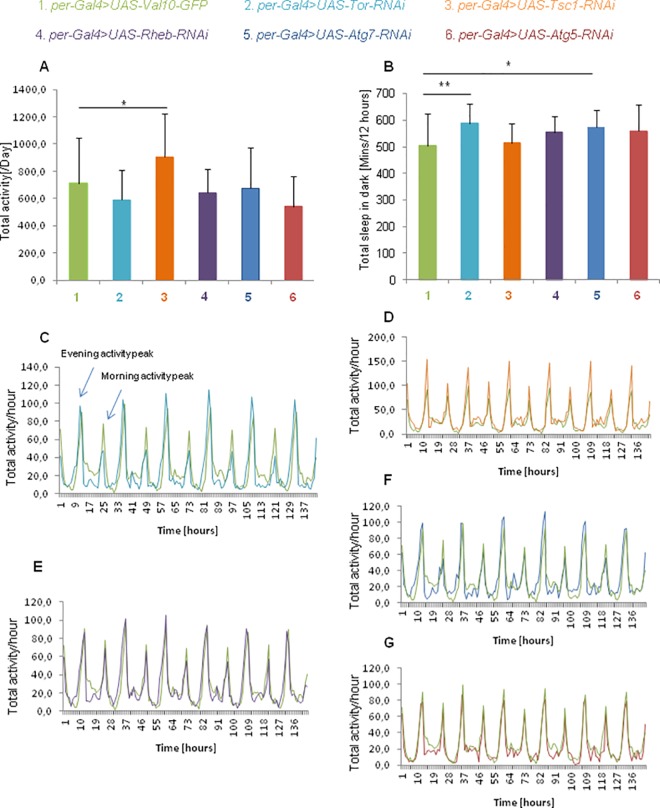
Sleep and activity of flies with silenced expression of TOR signaling pathway and autophagy genes.(A)—The total activity of flies recorded on the second day of experiment (mean +/- SD). Silencing the Tsc1 gene in per-positive cells increased the total activity of the flies [U Mann-Whitney Test, * for p≤0,05]. (B)—Total sleep of flies in the dark phase (mean +/- SD). The flies with silenced expressions of Tor or Atg7 gene had lengthened sleep durations in the dark [U Mann-Whitney Test, ** for p≤0,01, * for p≤0,5]. (C)–The sleep metrics of flies with silenced expression of the Tor gene in per-positive cells (x axis shows the time in hours). These flies were less active than control flies during the morning peak of activity but were more active during the evening peaks. (D)—The sleep metrics of flies with silenced expression of the Tsc1 gene in per-positive cells. The experimental flies were more active than control flies during the entire recorded period, regardless of the time of day. (E)—The sleep metrics of flies with silenced expression of the Rheb gene in per-positive cells. Experimental flies were less active during morning peaks of activity in comparison to control flies. (F)—The sleep metrics of flies with silenced expression of the Atg7 gene in per-positive cells. (G)—The sleep metrics of flies with silenced expression of the Atg5 gene in per-positive cells.